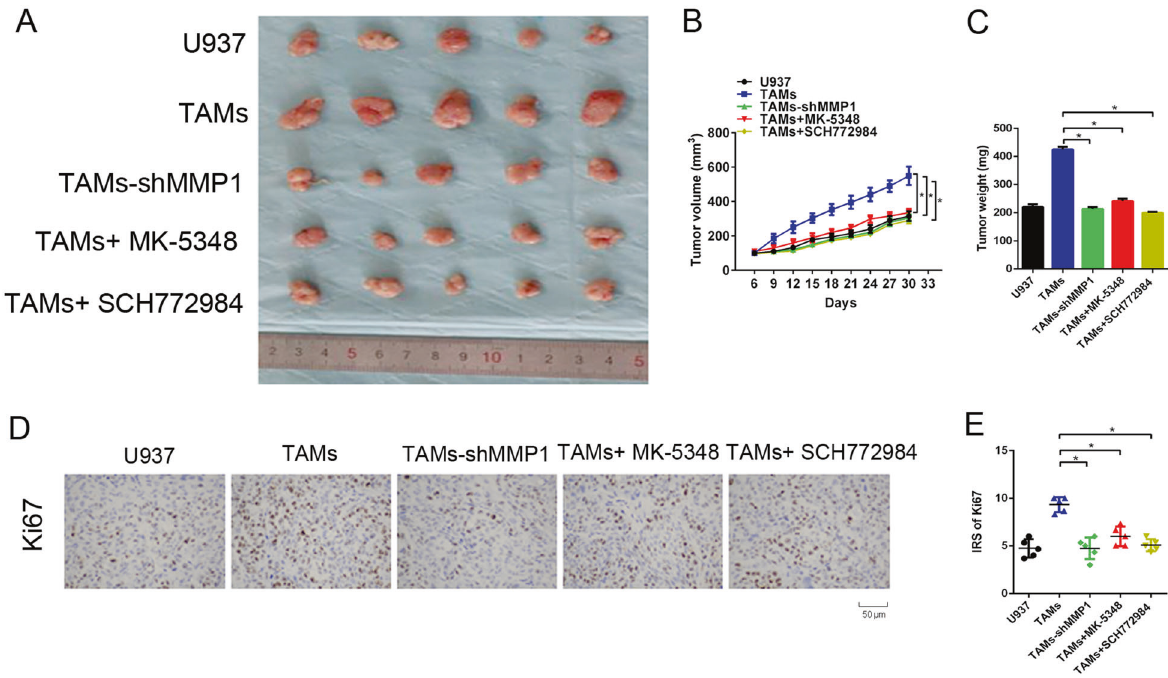
Fig. 6 Essential role of MMP1/PAR1/Erk1/2 axis in tumor formation of colon cancer cells. A Schematic representation of the tumor xenografts formed by TAMs and HT-29 cells cells with PAR1 inhibitor MK-5348 or Erk1/2 inhibitor SCH772984. B , C Tumor growth curves ( B ) and tumor weights ( C ) for tumor xenograft formed by TAMs and HT-29 cells cells with MK-5348 or SCH772984. D IHC staining for Ki67 in tumor xenografts formed by TAMs and HT-29 cells cells with MK-5348 or SCH772984. E Comparison of immunoreactivity scores (IRS) of Ki67 among the fi ve group. * P <